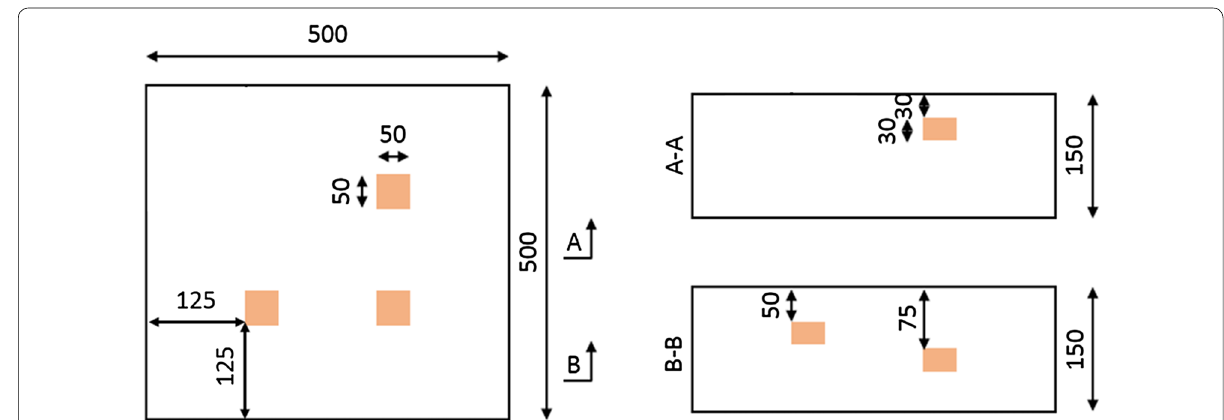
Fig. 10 Schematic of the test block used for the void detection experiment: a polystyrene block of 200 × 200 × 30 mm was placed at a depth of 30 mm in order to simulate a void type defect given the impossibility to induce a controlled volume of air inside a concrete block. (Dimensions specified in mm)